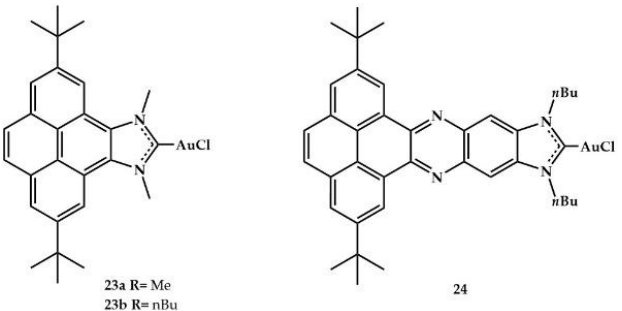
ligands with fused polycyclic aromatic hydrocarbons (Figure 10) [26].